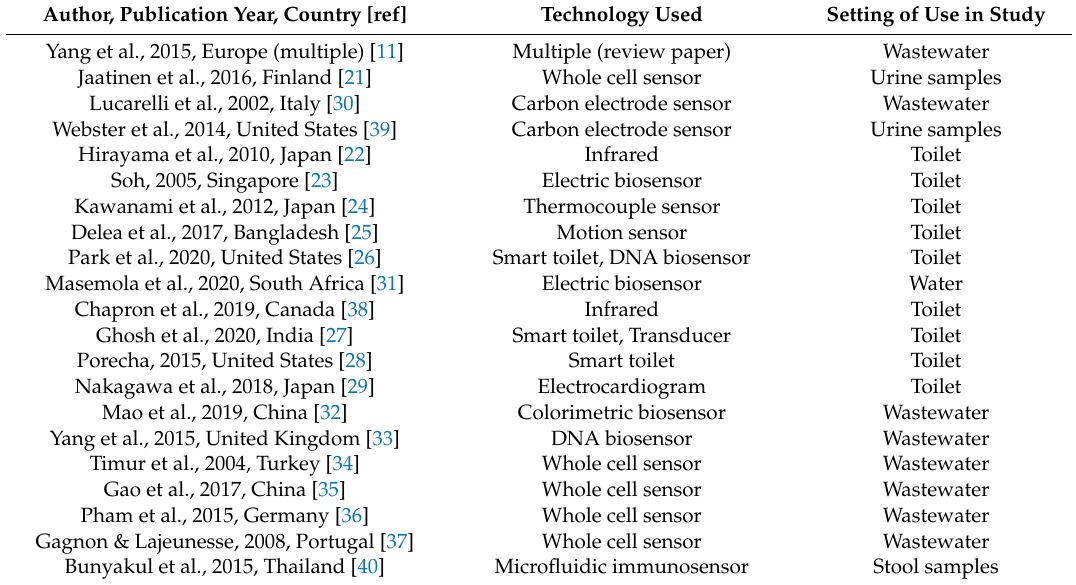
Table A1. Study Characteristics of Included